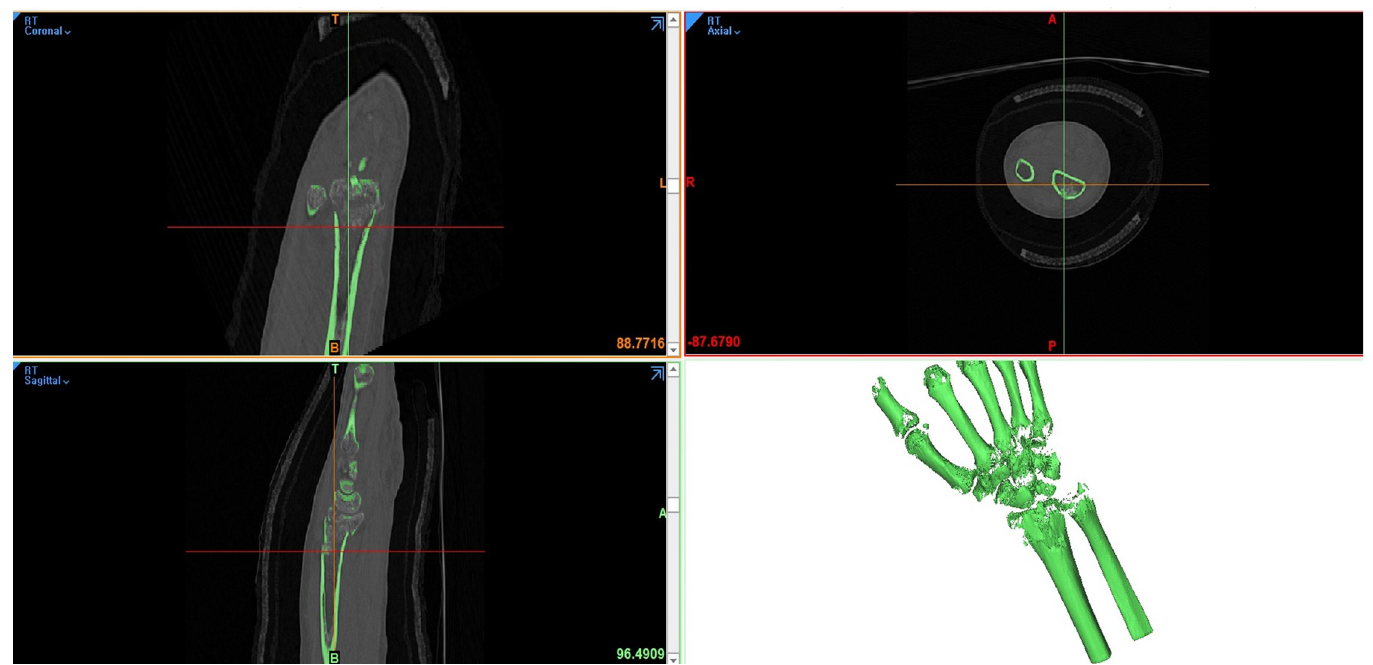
Fig 2. A screenshot of the 3D reconstruction modeling software. Digitalized CT data in DICOM format were imported and the coronal, sagittal, and axial views of the CT data were obtained in Mimics 1 (Mimics 1 22.0, Materialise, Antwerp, Belgium). The green–colored reconstruction image in the right bottom shows a density mask. Voxels with attenuation above 850 HU in CT images converted to density masks in the Mimics 1 software.